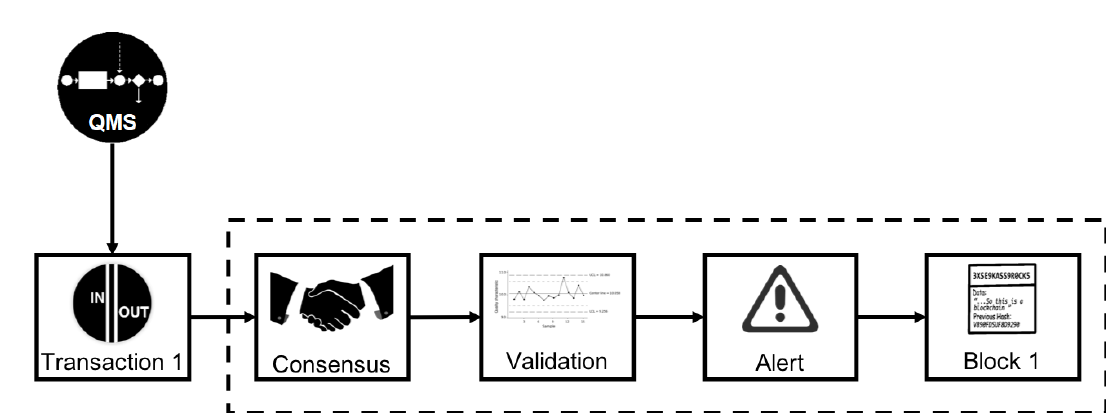
Figure 3: Process that occurs inside the Blockchain every time, prior to store a transaction.